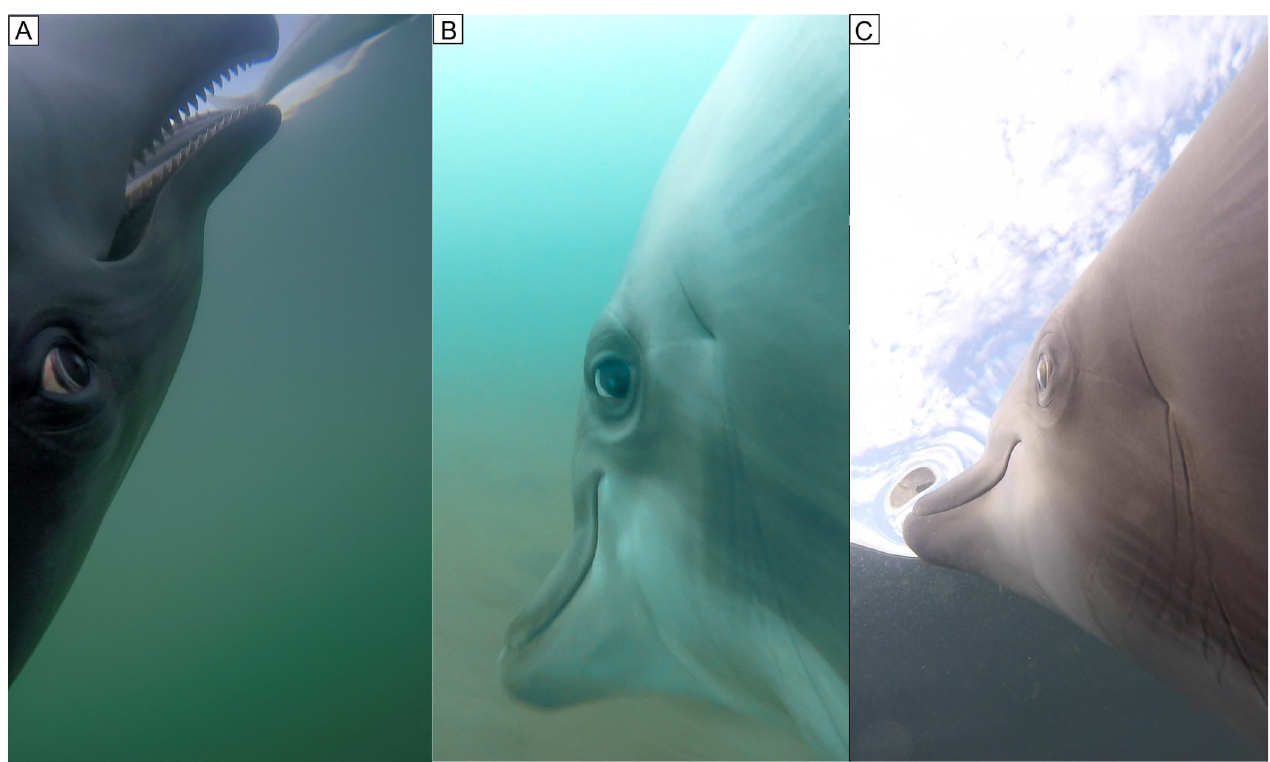
Fig 4. Dolphin S visually tracks fish by rotating eye. A . During a surface chase, the dolphin visually tracks a fish by turning upside down and by rotating the eye forward displaying the posterior sclera. B . The dolphin rotates the eye backward displaying the anterior sclera as a fish escapes to the rear of the dolphin. Note the depression under the eyeball attending the backward rotation. C . Dolphin S eye without a depression